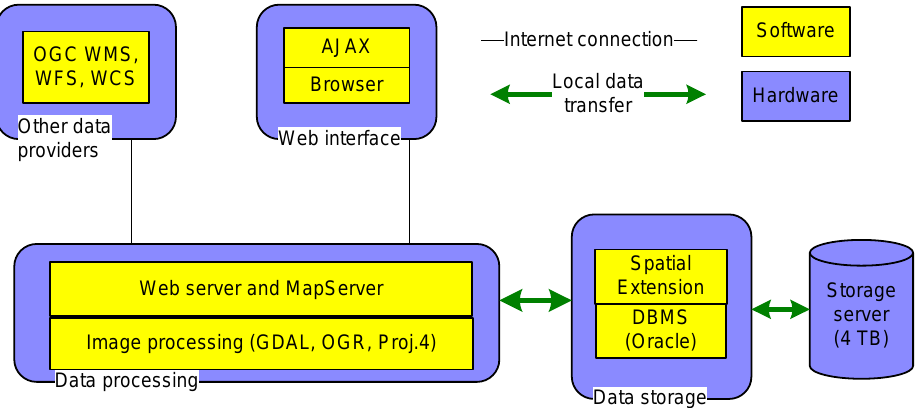
Figure 1. Schematic diagram of DNPG system